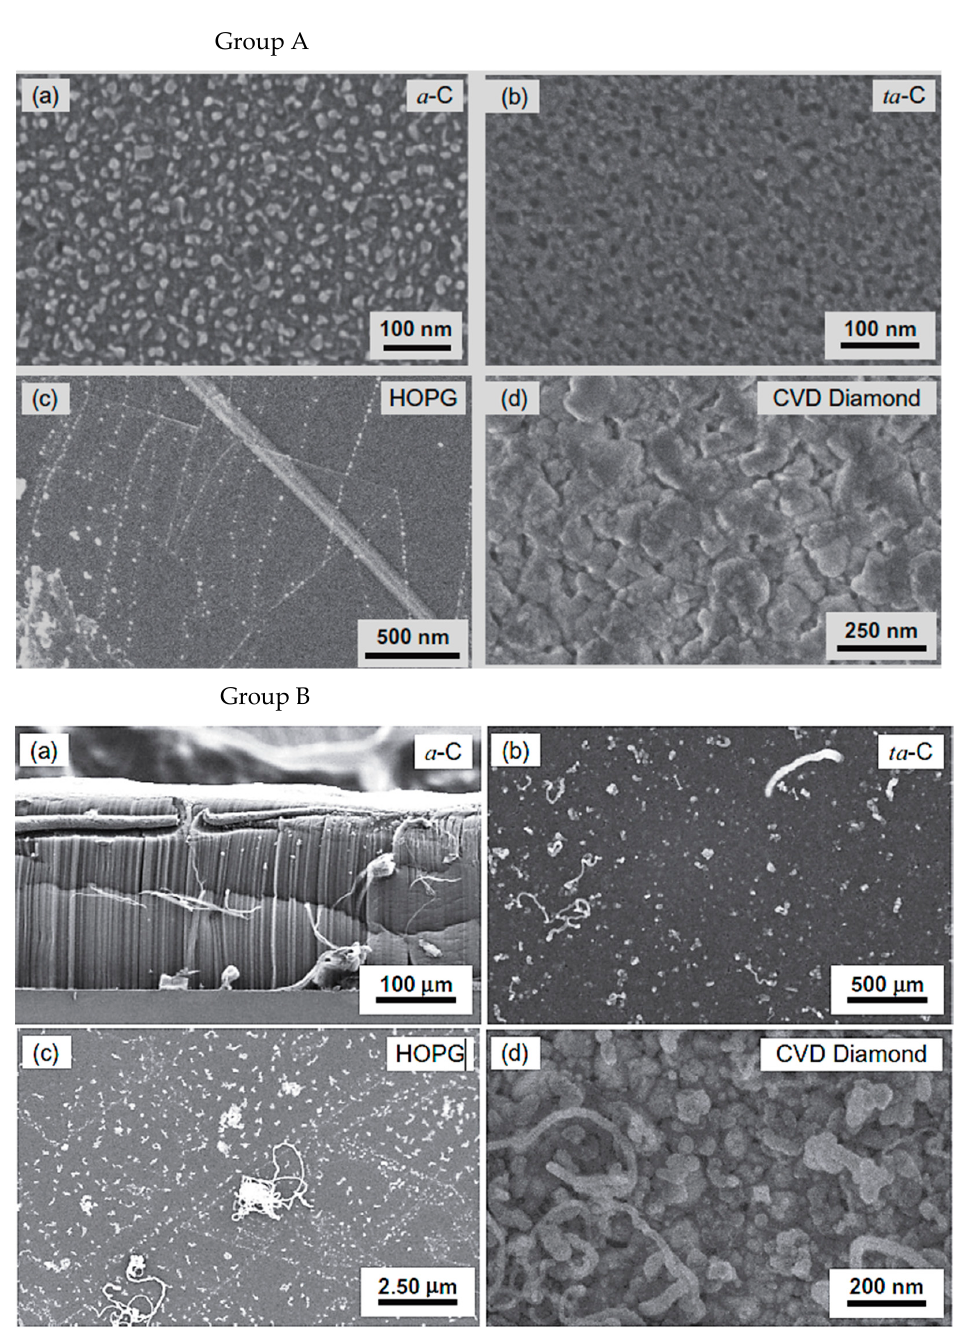
Figure 19. Group A —Top-view micrographs obtained by scanning electron microscopy (SEM) of Fe catalyst nanoparticles deposited on four different sp 2 :sp 3 carbons: (a) (a-C, 85:15 sp 2 :sp 3 ), (b) (ta-C, 30:70 sp 2 :sp 3 ), (c) (HOPG, 100:0 sp 2 :sp 3 ), and (d) (CVD diamond, 0:100 sp 2 :sp 3 ). Group B —idem as in Group A after CVD synthesis of VACNT. Micrographs in Group B —(a) presents cross-section view, whereas (b–d) present top-view. Reprinted with permission from Cartwright, Carbon; Ref. [32] copyright 2014, Elsevier.